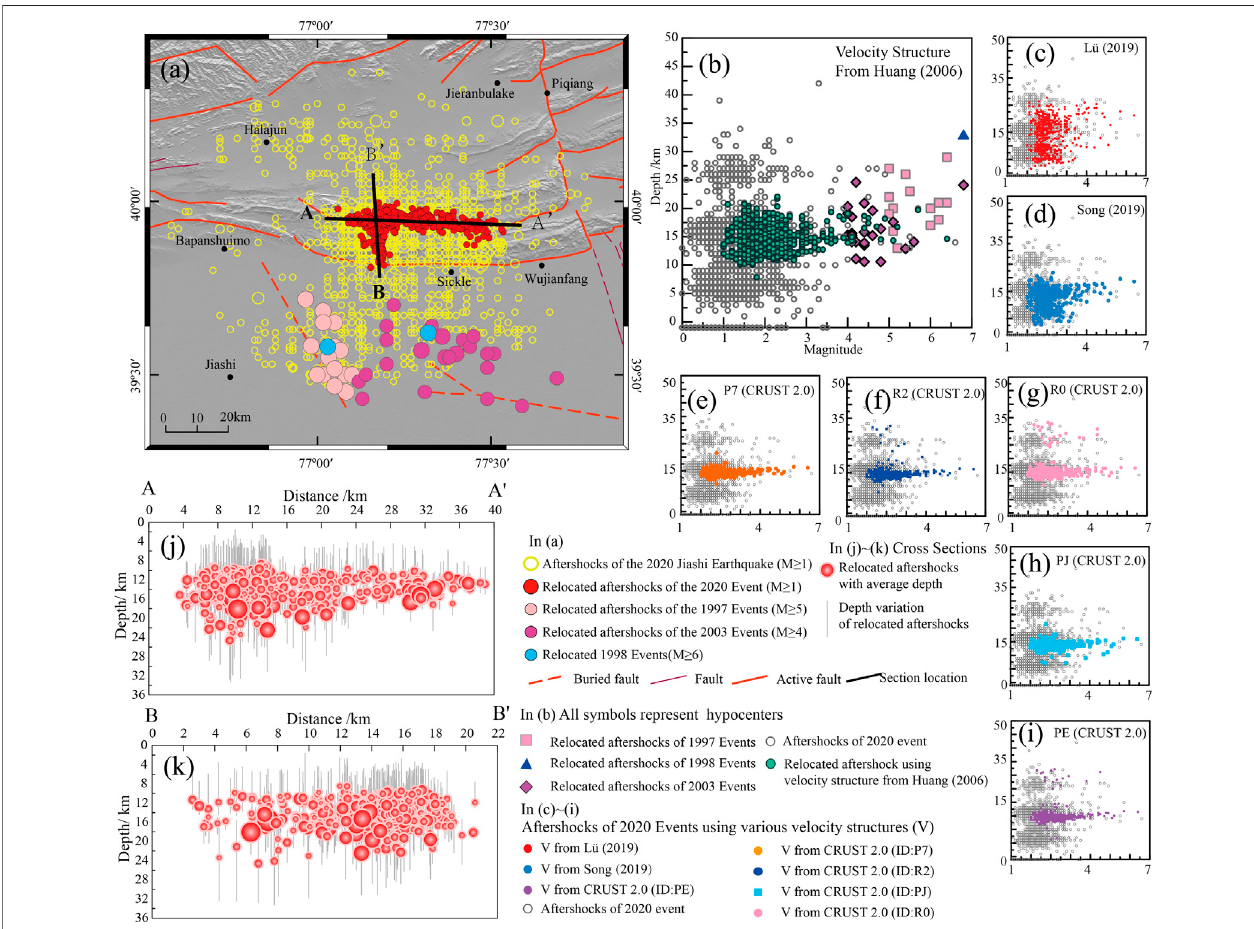
FIGURE 4 | (A) Comparison of the relocated sequences of the 1997, 1998, 2003 and 2020 earthquake that occurred in and around the Kaping fold-and-thrust belt. The pink circles, the purple circles, and the blue circles respectively show the relocated aftershocks and main events of the 1997 earthquake swarm ( M S 5) (Zhou and Xu, 2000), the 2003 Bachu-Jiashi earthquake (Huang et al., 2006), and the 1998 earthquake (Guo et al., 2002), respectively. (B) – (I) Distribution patterns of the depths determined with eight different velocity models of the 2020 Jiashi earthquake and a comparison with the relocated depths of the 1997, 1998, and 2003 events (J), (K) Cross sections of the relocated aftershocks of the 2020 Jiashi sequence. The pro fi le positions are presented as thick black lines in (A) .